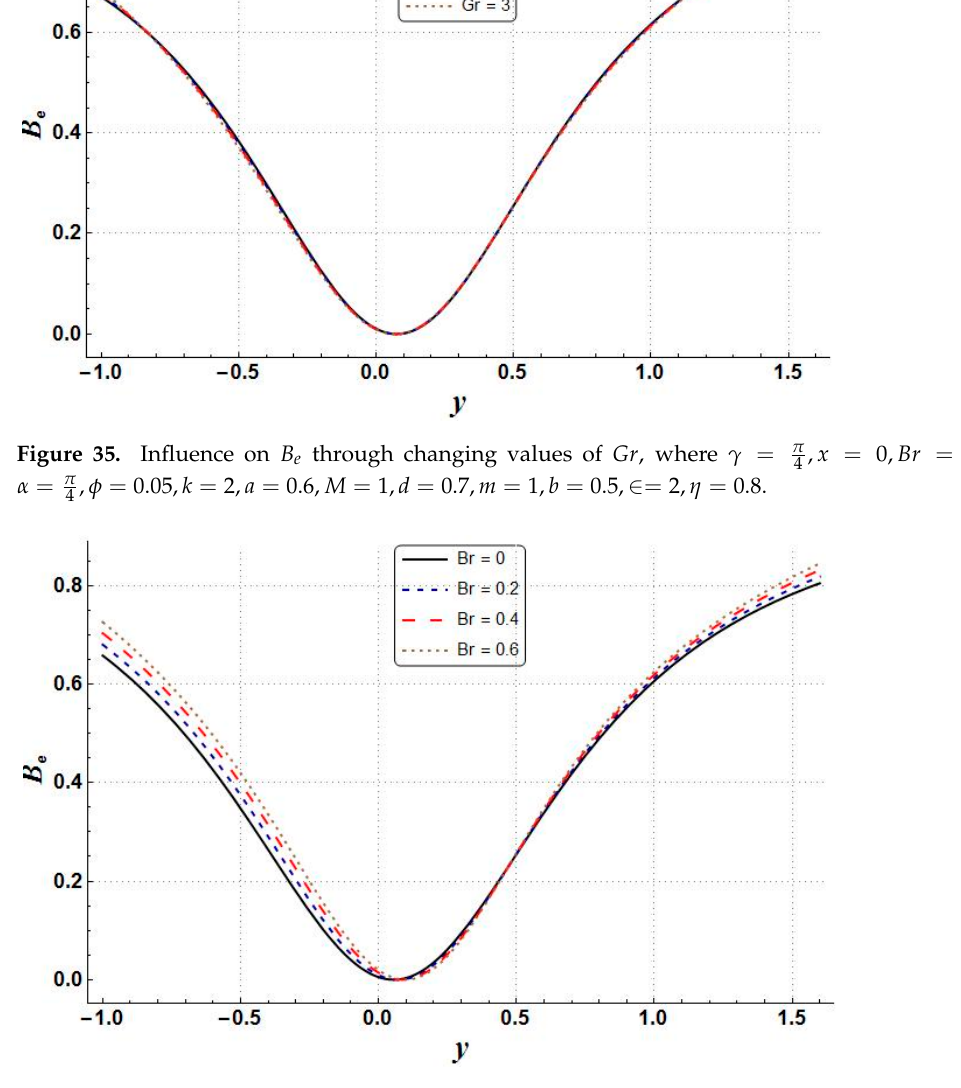
, x = 0, Gr = 2, α = π 4 Br , where